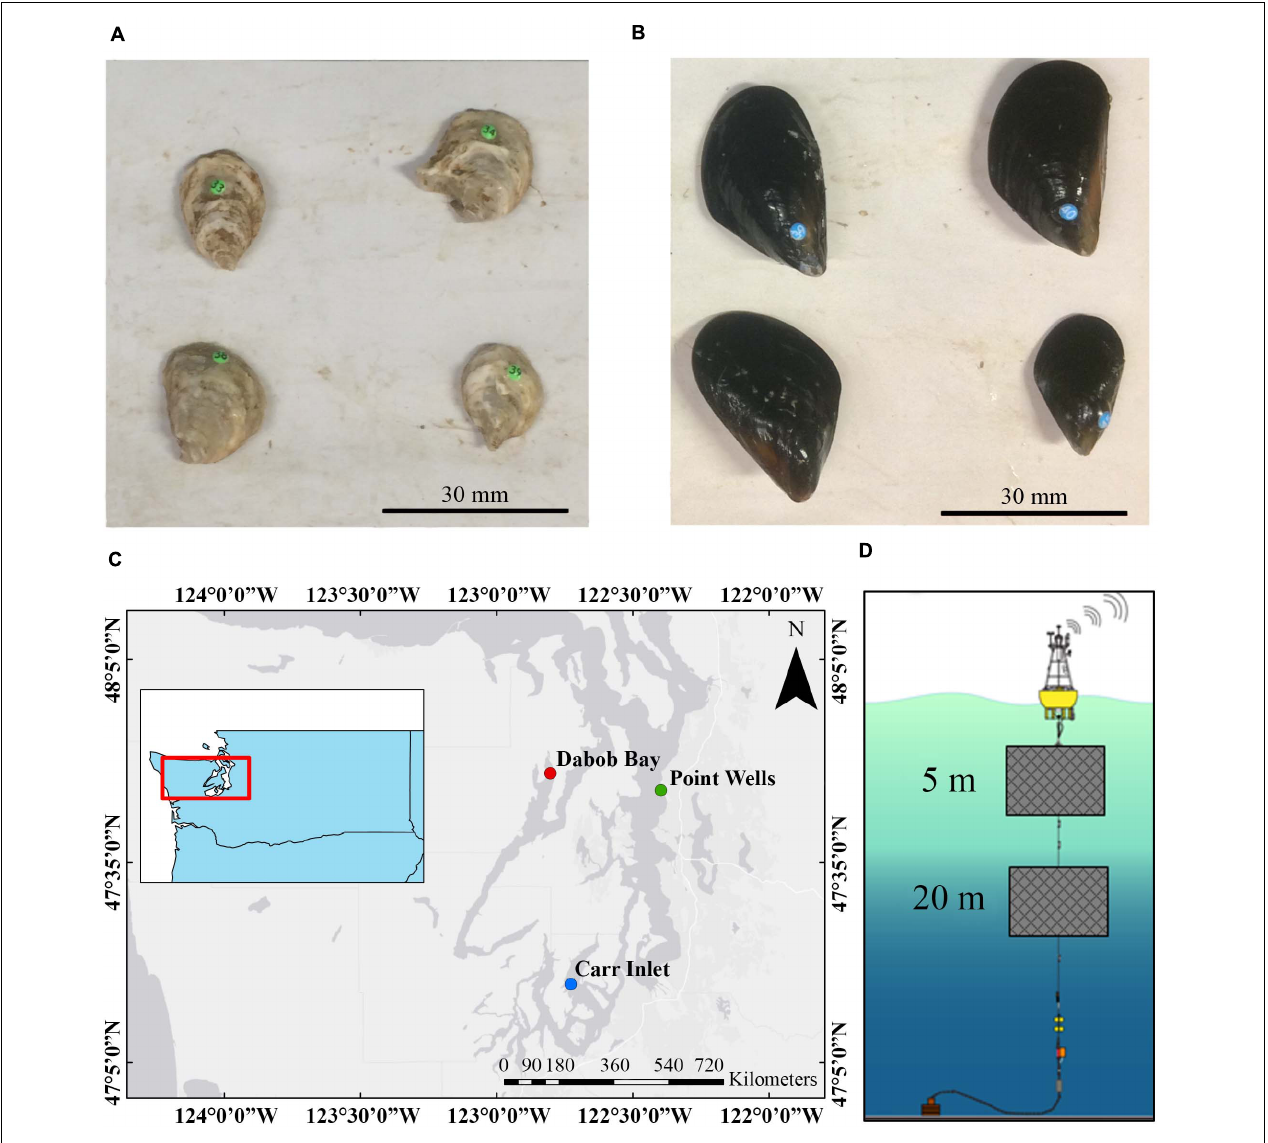
FIGURE 1 | (A) Photograph of oysters in June 2018. (B) Photograph of mussels in June 2018. (C) Map of Puget Sound showing the locations of ORCA buoys where shellfish were deployed. Oysters and mussels were deployed at Dabob Bay (Hood Canal) at 5 m depth, Point Wells (central Puget Sound) at 5 m depth, and Carr Inlet (south Puget Sound) at both 5 m and 20 m depths. (D) A diagram of how shellfish were deployed below ORCA buoys in the field. Diagram adapted from Northwest Environmental Moorings group, Applied Physics Laboratory, University of